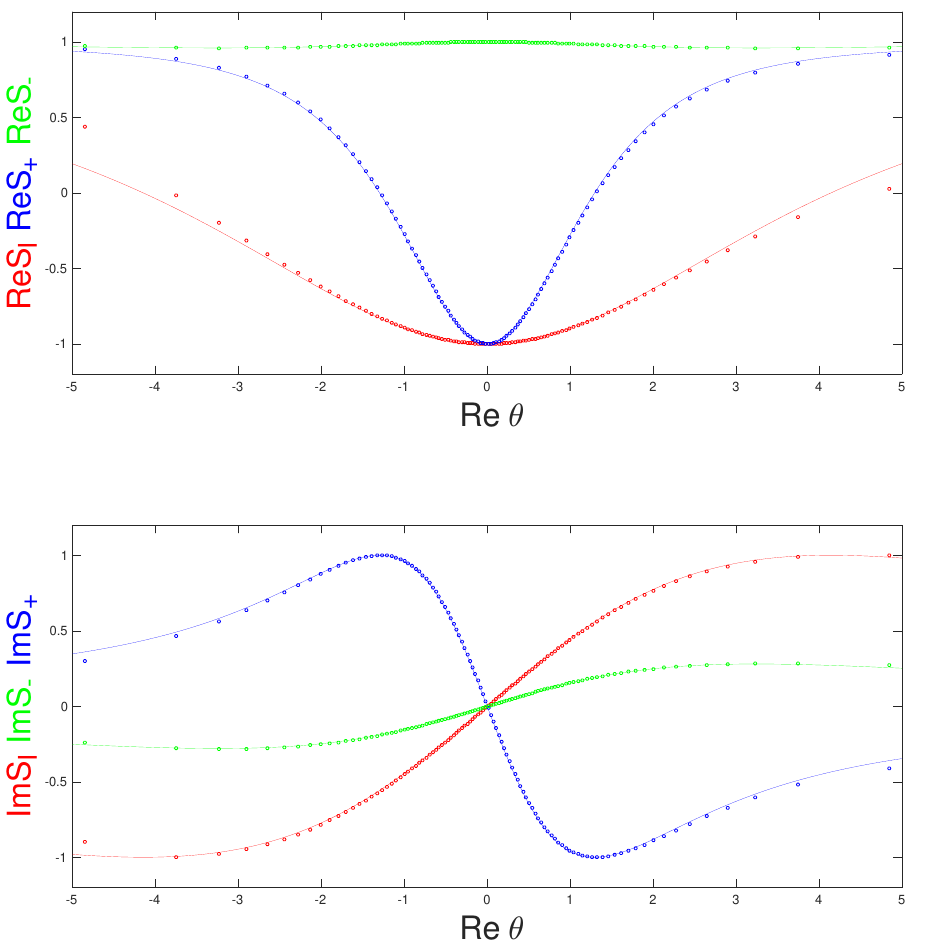
Figure 4. The comparison of the maximization results with the exact integrable model for N = 6. We use 200 points for interpolation and choose an initial functional F = Re[ S 1 ( (cid:18) 0 ) (cid:0) (cid:11)S 2 ( (cid:18) 0 )] with (cid:18) 0 ’ i ( z 0 = 0 : 3 i ) and (cid:11) = 7 : 5. Here we plot the real and imaginary parts of S I , S + and S (cid:0) on the physical line where the dots indicate maximization results while the curves are the exact integrable